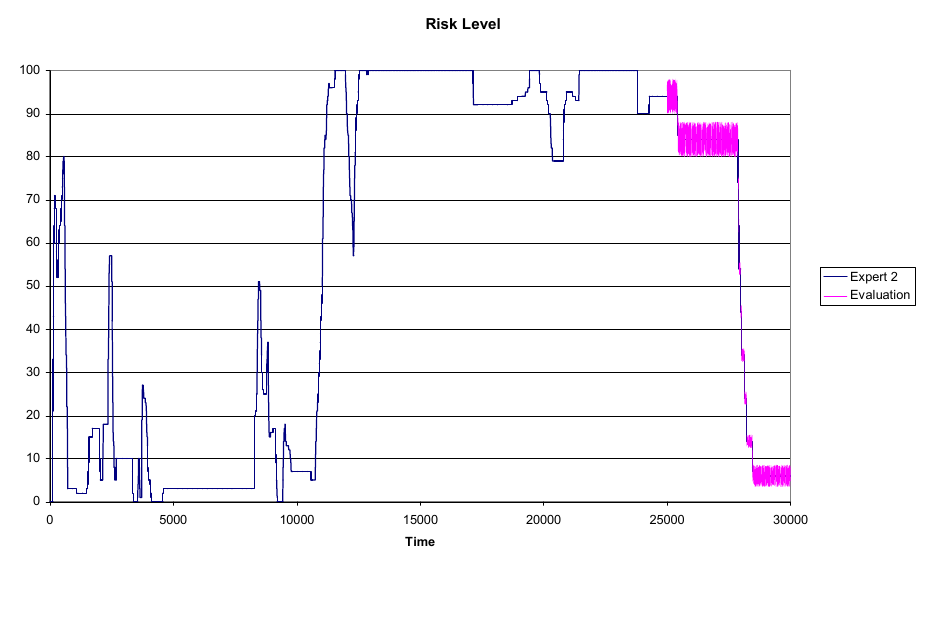
Figure 7. Driving risk evaluation given by Expert 2 (n = 25.000 and Tn =